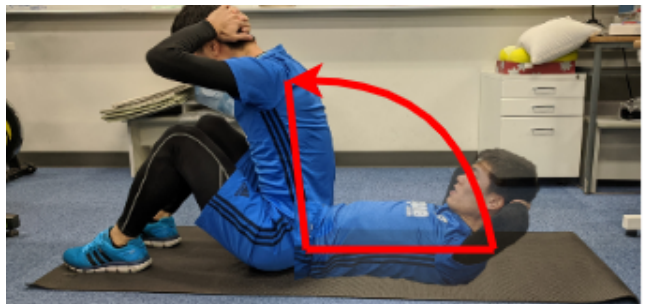
Figure 8. The change of the most moving axis during one sit-up.